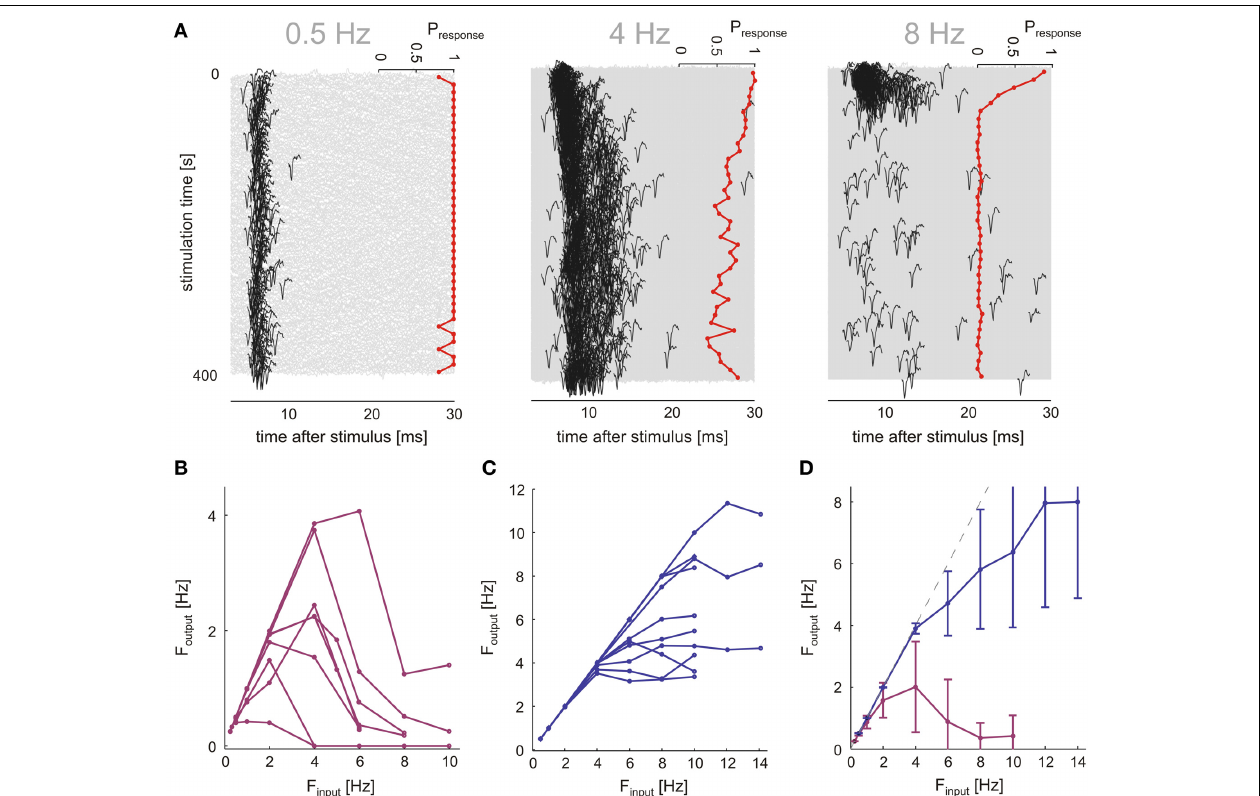
FIGURE 4 | Synaptic layer imposes low-pass filter on neuron input. Networks ( n = 7) were stimulated by a single electrode, responses were classified into synaptic ( n = 8) and direct responses ( n = 10) by the extent of delay at threshold stimulation amplitude in an experiment shown in Figure 2 . (A) Response transients at different stimulation frequencies in a synaptically stimulated neuron are shown. All response traces within a 400s stimulation session are plotted (gray), first spikes (black) indicated by using identical voltage scales. Binned response probabilities (bin size =